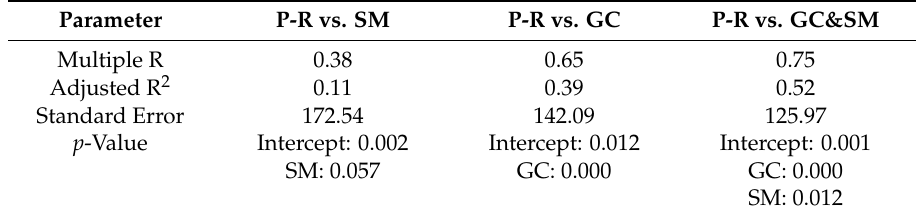
Table 3. Statistical parameters of multilinear regression analysis of rainfall–runoff residuals (P-R) versus ground cover (GC) and soil moisture (SM). Sample size is 26. Parameter P-R vs.